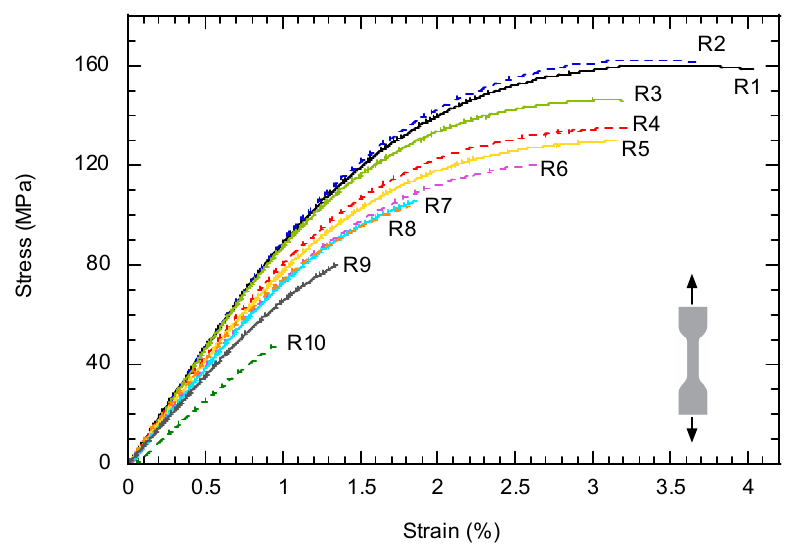
Figure 4. Experimental curves obtained in the tensile tests. Three tests were carried out for each material condition (number of recyclings); for clarity, only one of them was included in the graph.